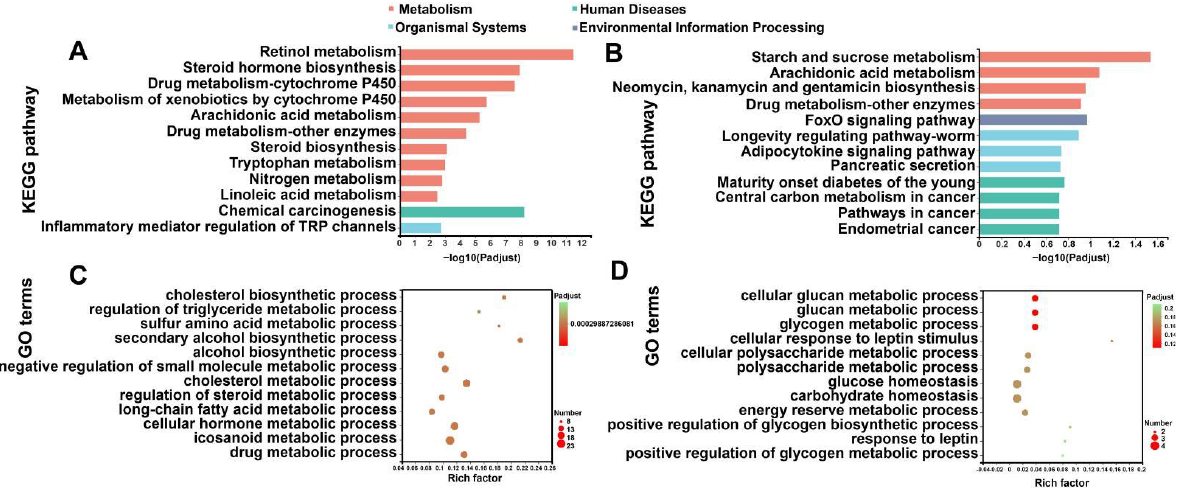
Figure 5. KEGG and GO enrichment analysis of altered gene sets in liver. ( A ) KEGG enrichment analysis of DEGs between CON and HFD groups; ( B ) KEGG enrichment analysis of DEGs between HFD and HFD+DHQ groups; ( C ) GO classification of DEGs between CON and HFD groups; and ( D ) GO classification of DEGs between HFD and HFD+DHQ groups. The vertical axis represents GO terms and the horizontal axis is the Rich factor. The size of each point indicates gene numbers in this GO Term.